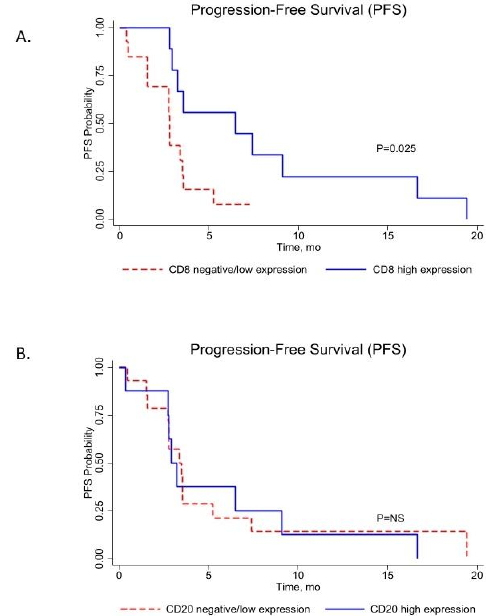
Figure 2. Kaplan–Meier plots of progression-free survival (PFS) between ( A ). CD8 high and CD8 low, and ( B ). CD20 high and CD20 low TIL score groups with log-rank P value.